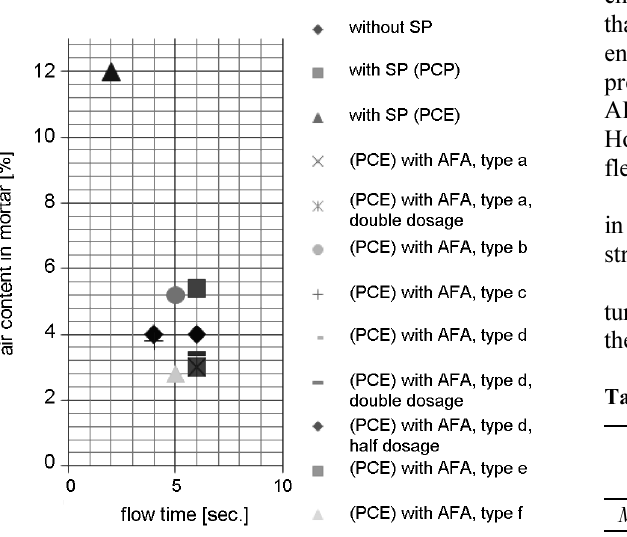
Fig. 2. The influence of the type of AFA and SP on the relation- ship between the flow diameter and air content in mortar